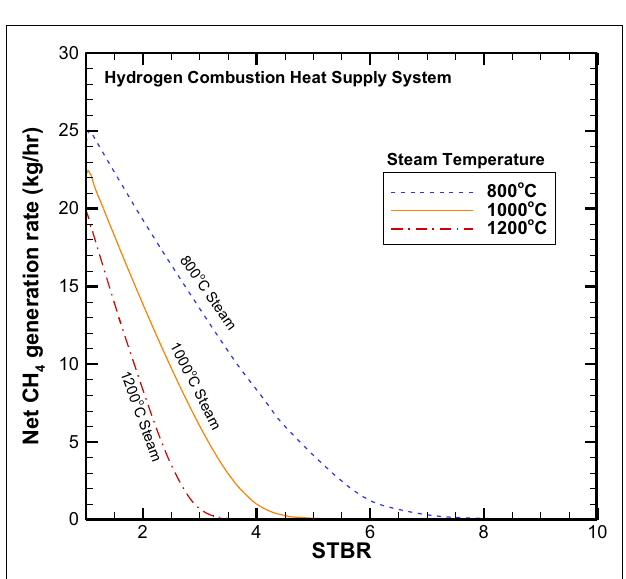
FIGURE 8 | Net methane generation rate for concept system I as a function of STBR .